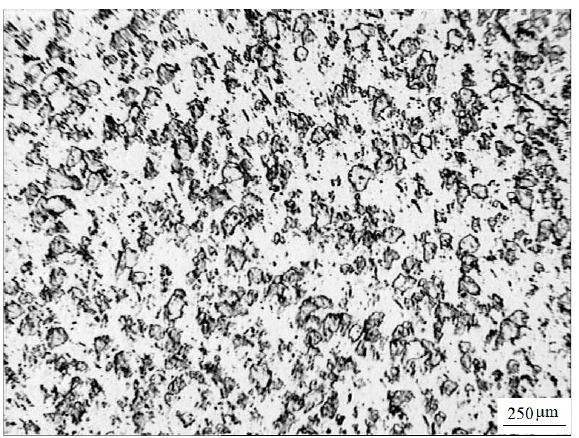
Figure 3. Microstructure of the specimen quenched with 9 Hz, 500 V, 3 min and 400 μ F (cid:2) 120 .